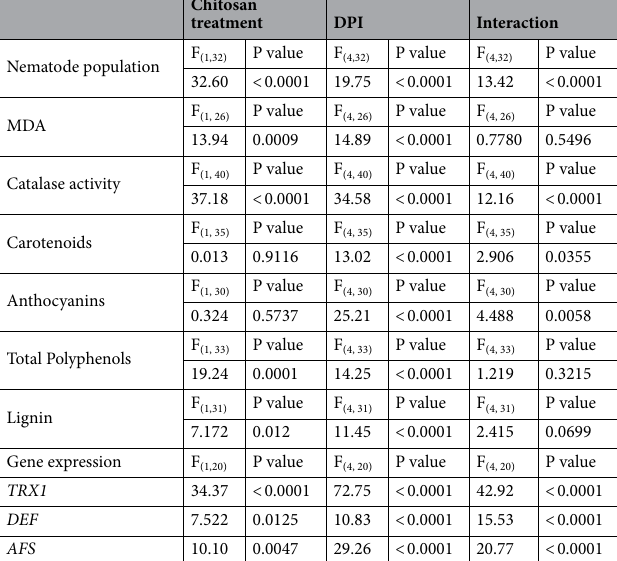
Table 1. Effect of chitosan treatment, time-points of analysis (days post-inoculation, DPI) and their interaction in the physiological, biochemical and gene expression analyses of control and inoculated P. pinaster plants, following elicitation with